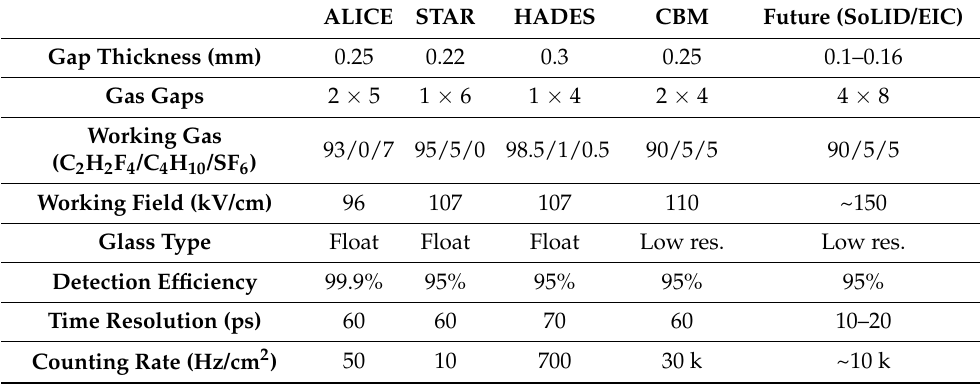
Table 3. Parameters and features of different MRPC detectors used in several large experiments. The counting rate is the highest rate capability of MRPC detectors.